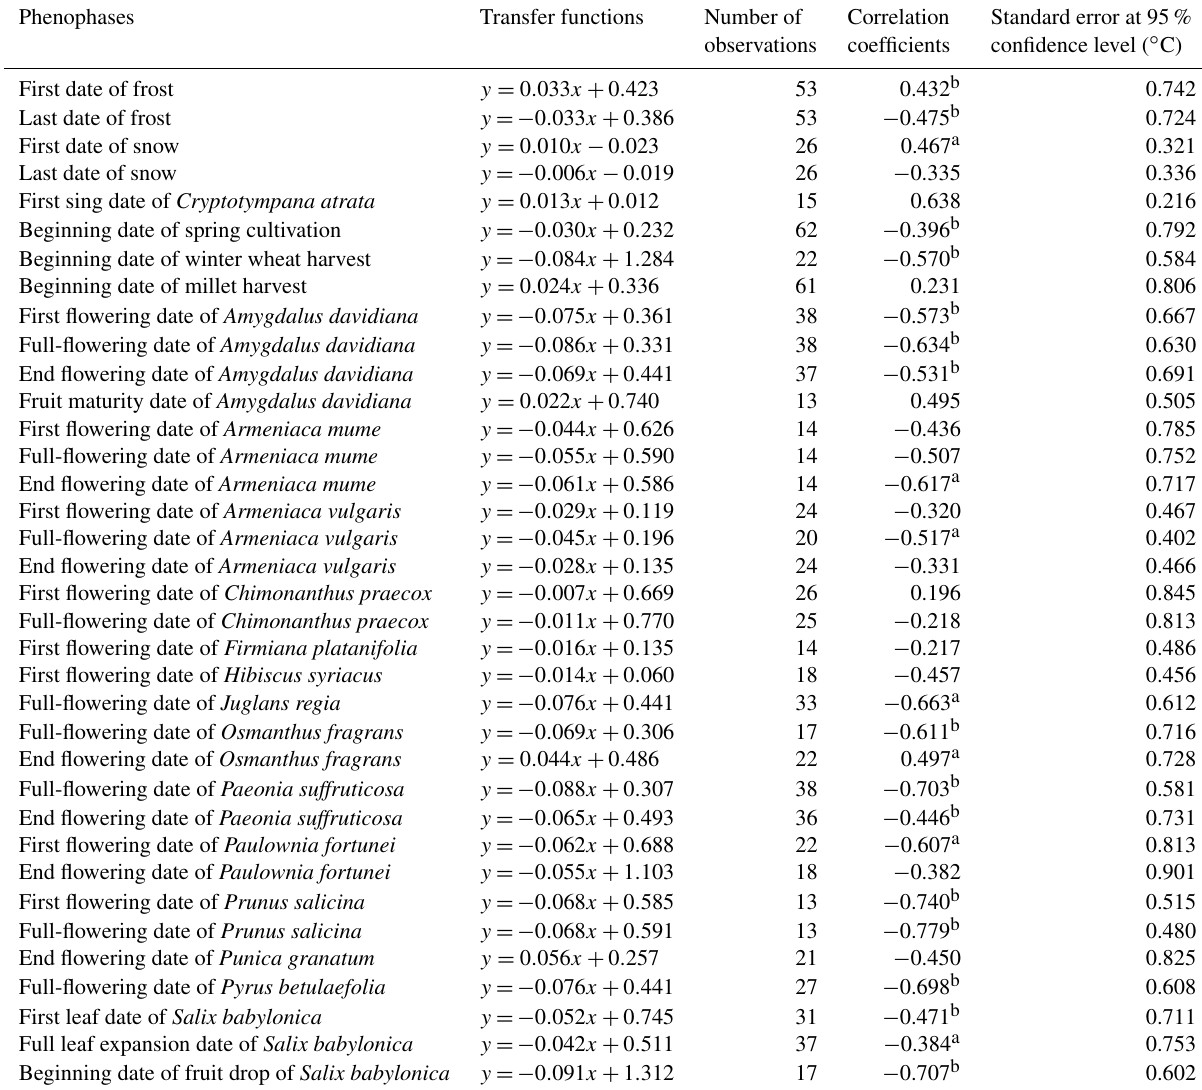
Table C1. Transfer functions for the temperature reconstructions based on phenological records obtained from Liu et al. (2016) and from poems in this